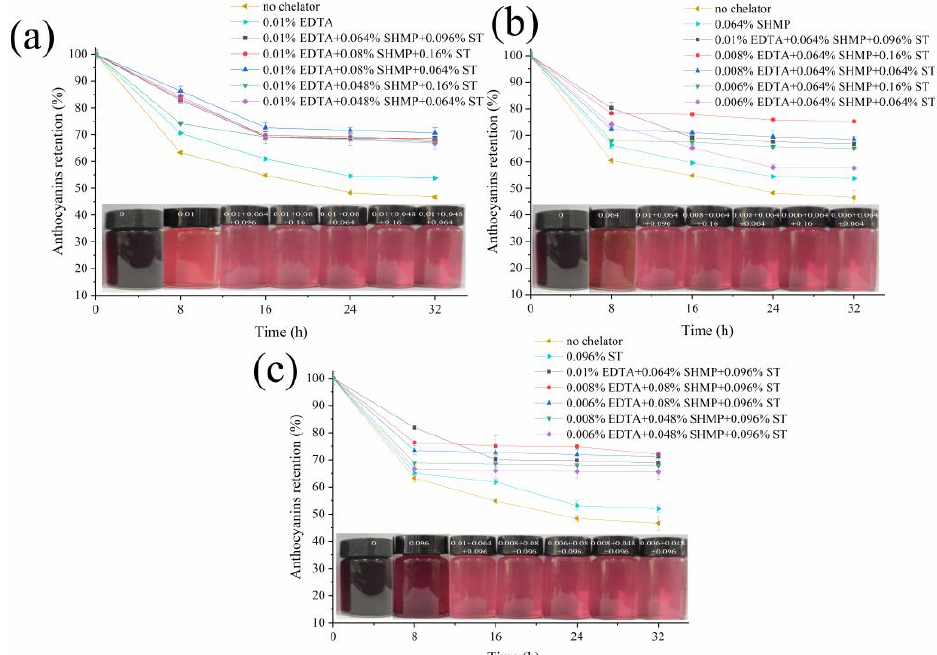
Figure 3. Effect of the combination of ethylenediaminetetraacetic acid disodium salt (EDTA, ( a )), sodium hexametaphosphate (SHMP, ( b )), and sodium tartrate (ST, ( c )) with the other two chelators on the color stability of the tap-water dissolved 0.02% ( w/v ) BRA solution as a function of storage time. The insets are the appearances of the corresponding tap water-dissolved 0.02% BRA solutions containing the chelators formulations after storage for 32 h.